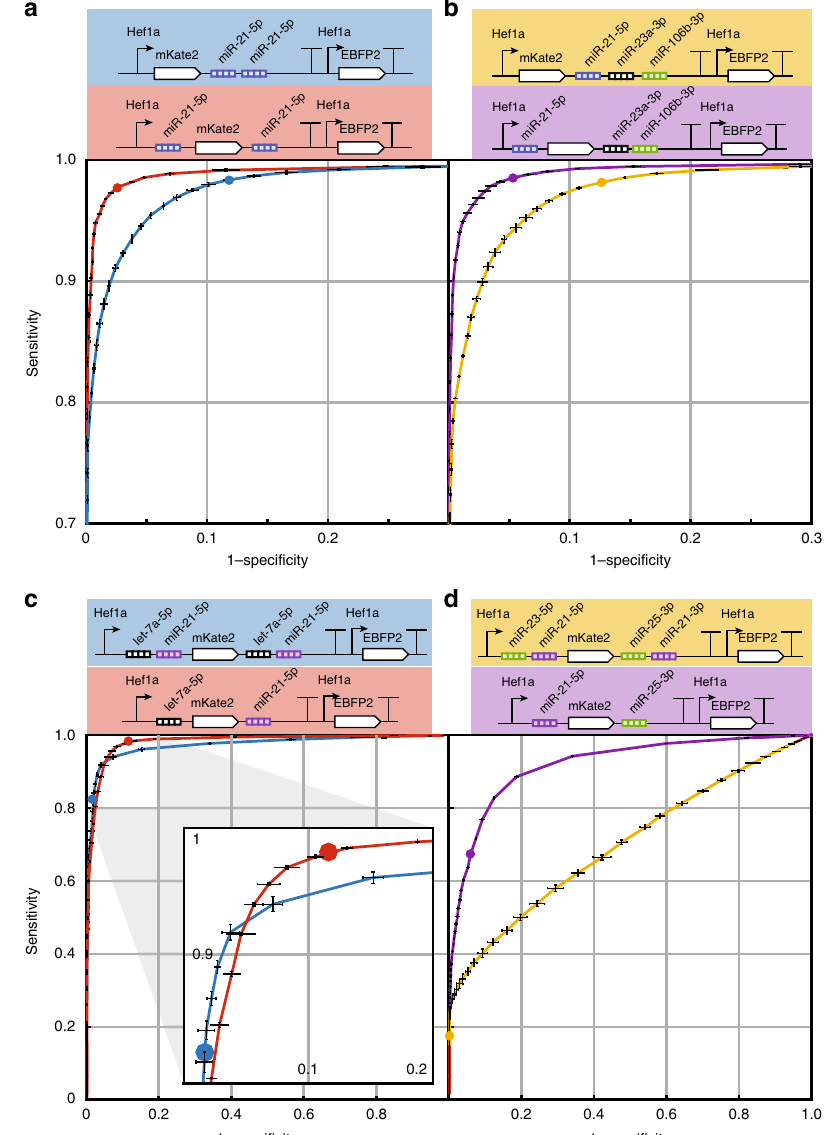
Fig. 8 ROC curves for classi fi ers illustrate speci fi city and sensitivity tuning by miRNA target set location and number. Receiver operator characteristic (ROC) curves derived from data in Figs. 6 and 7 were generated by calculating sensitivity and speci fi city at varying the mKate2 thresholds (previously fi xed at 10 2 ). For reference, circles along the curves show sensitivity and speci fi city at the fi xed threshold used for Figs. 6 and 7. a Circuit diagrams and ROC curves for miRNA classi fi ers with varying target site position as tested in Fig. 6. Circuit shading color corresponds to ROC curve color. The classi fi er with miR-21-5p target sets in different UTRs (red) shows greater maximal accuracy compared to that with target sites in only the 3 ′ UTR (blue) as indicated by nearer approach towards the upper left and greater area under the curve (AUC = 0.9947 vs 0.9895). b Similarly, the 3-input classi fi er with miR-21-5p in the 5 ′ UTR and miR-23a-3p and miR-106b-3p in the 3 ′ UTR (purple) exhibits better overall classi fi cation than the variant with target sets in only the 3 ′ UTR (yellow), with AUCs of 0.9952 and 0.9881, respectively. c Circuit diagrams and ROC curves for miRNA classi fi ers with or without target site duplication across UTRs for let-7a-5p and miR-21-5p. Data for c and d correspond to that from Fig. 7. Both classi fi er variants show similar maximum accuracy when classifying between HEK293FT and HeLa cells, though at the example threshold of 10 2 the variant without duplication (red, AUC = 0.9833) prioritizes sensitivity while the variant with target set duplication (blue, AUC = 0.9750) prioritizes speci fi city (see inset for magni fi ed view). d For classi fi ers with target sites for miR-25-3p and miR-21-5p, the circuit without duplication (purple, AUC = 0.9235) exhibits better classi fi cation compared to that with duplication (yellow, AUC = 0.7018), since repression was determined by both miR-25-3p and miR-21-5p rather than being dominated by miR-21-5p and also since potential uORFs are avoided by removing miR-25-3p targets from the 5 ′ UTR (both effects enhance sensitivity). Error bars indicated s.d. calculated by threshold averaging from three technical repression there is due to translational repression. Interestingly, with our data, provide the attractive hypothesis that other RNA for the RNA binding protein LIN41 in C . elegans , different binding proteins like Ago may use a similar mechanism to modes of repression have been observed depending on UTR mediate different modes of repression depending on location location (i.e., translational repression in the 5 ′ UTR and mRNA within the UTRs. Our results highlight the need for further destabilization in the 3 ′ UTR) 44 . Results for LIN41 combined studies on elucidating differences between repression from the